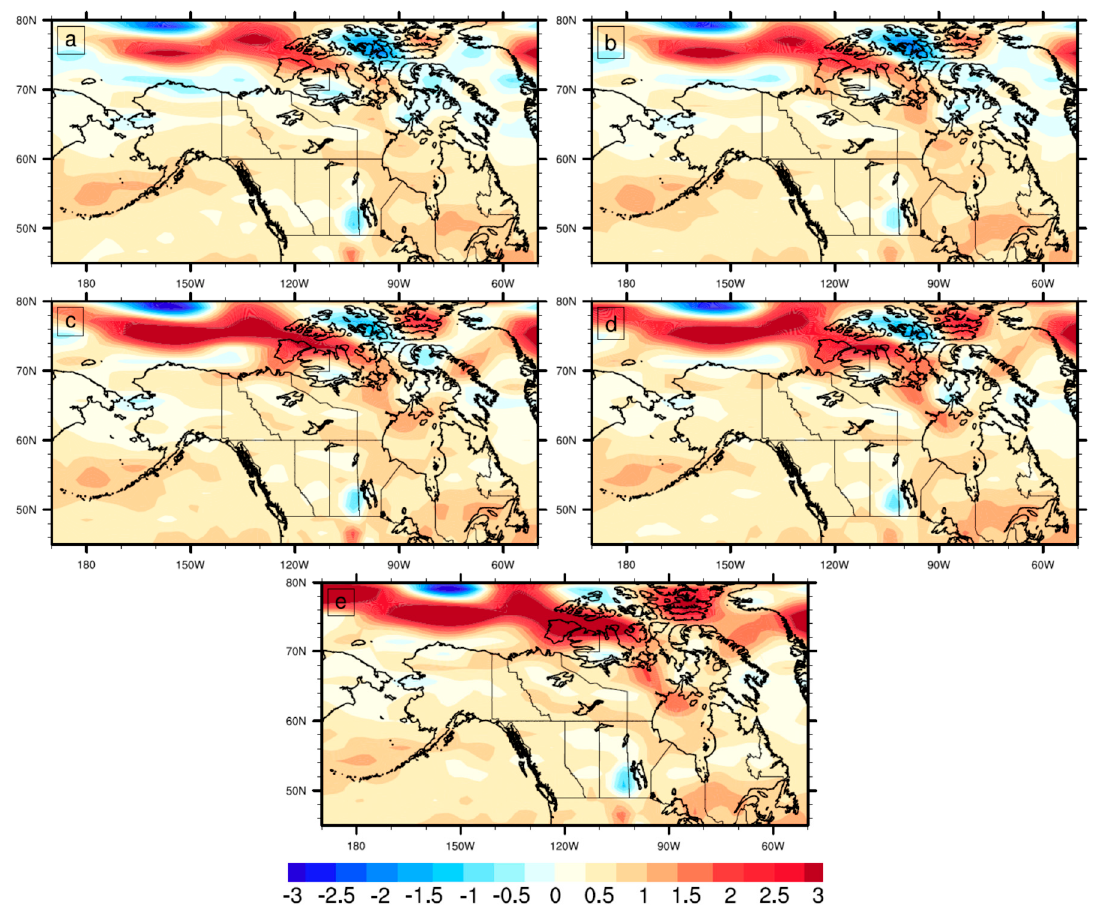
Figure 8. Meridional temperature gradient (°C Km − 1 ) in ( a ) 1–15 January; ( b ) 16–31 January; ( c ) 1–14 February; ( d ) 15–28 February; ( e ) 1–11 March, 2019.